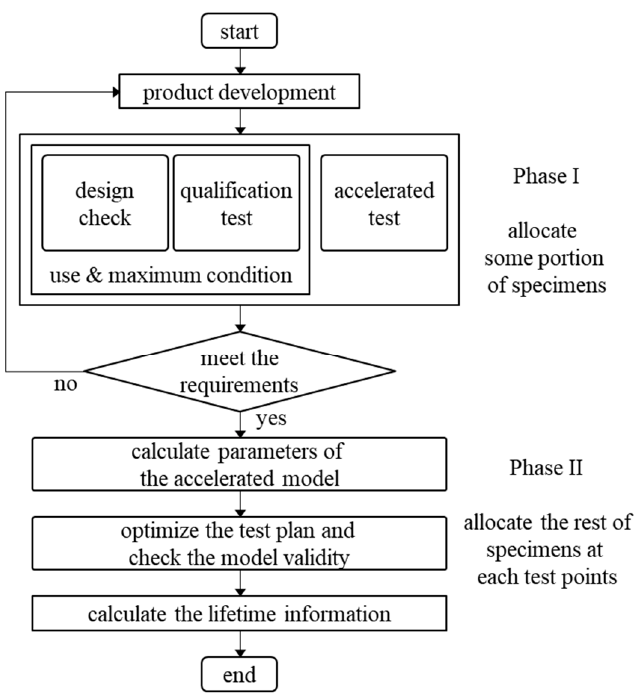
Figure 1. The two-phase process for the planning of PADT (practical partially accelerated degradation